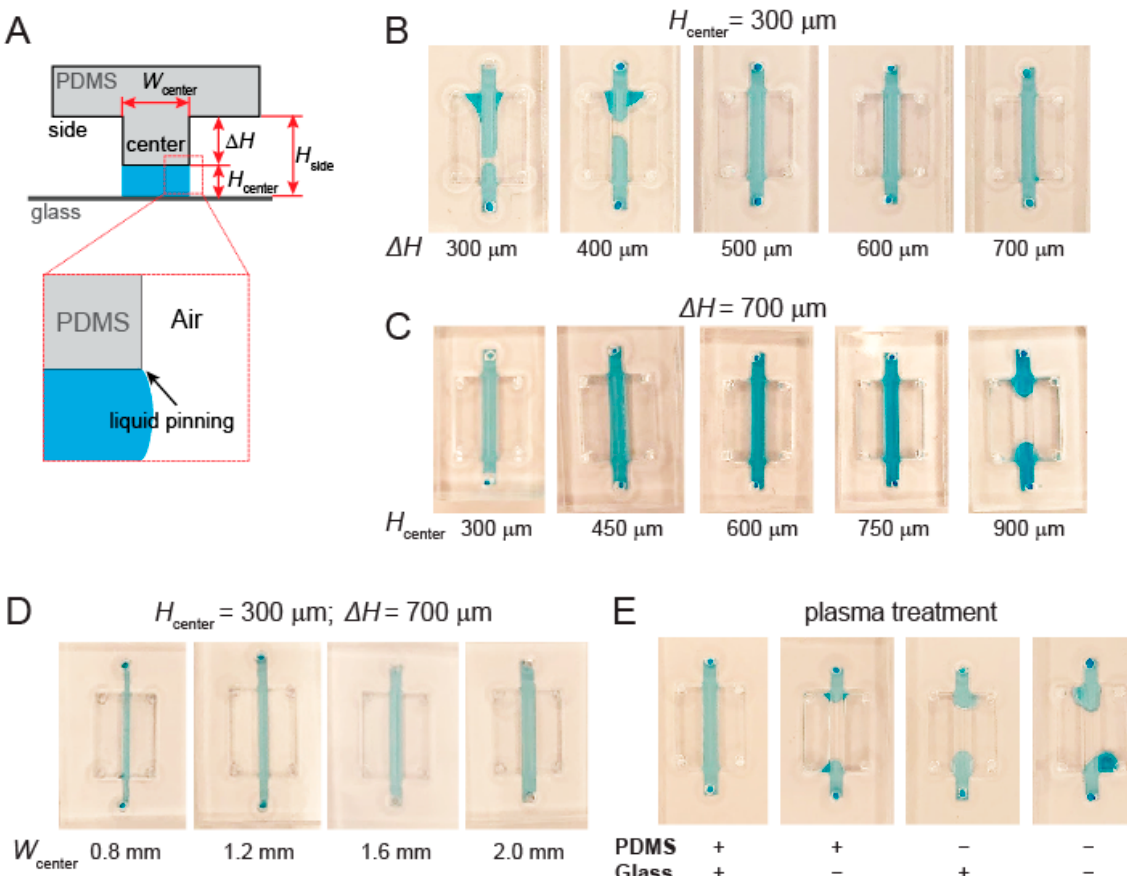
Figure 2. Dependence of liquid pinning on device parameters and surface treatment. ( A ) Illustration of key geometric parameters for liquid pinning. ( B ) Varying the height difference between the center and side channel with the height of the center channel kept constant (300 µ m). ( C ) Varying the height of the center channel with the height difference kept constant (700 µ m). ( D ) Varying the width of center channel with constant height of the center channel (300 µ m) and the height difference (700 µ m). ( E ) Effect of plasma treatment of the PDMS device and glass substrate on liquid pinning.